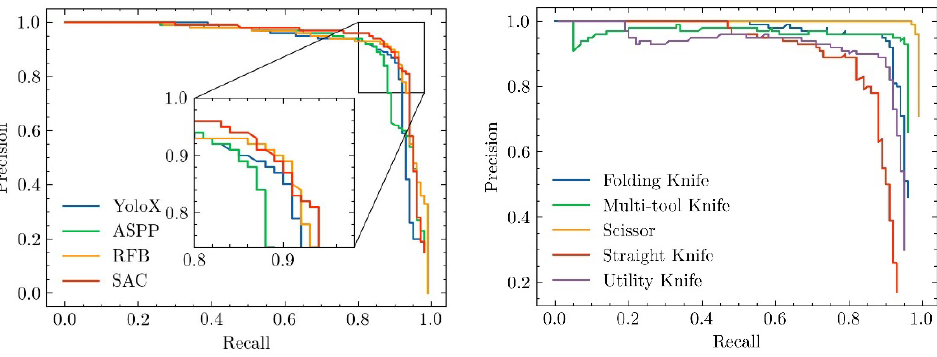
Figure 9. Comparison of P-R curves of different receptive field enhancement modules.